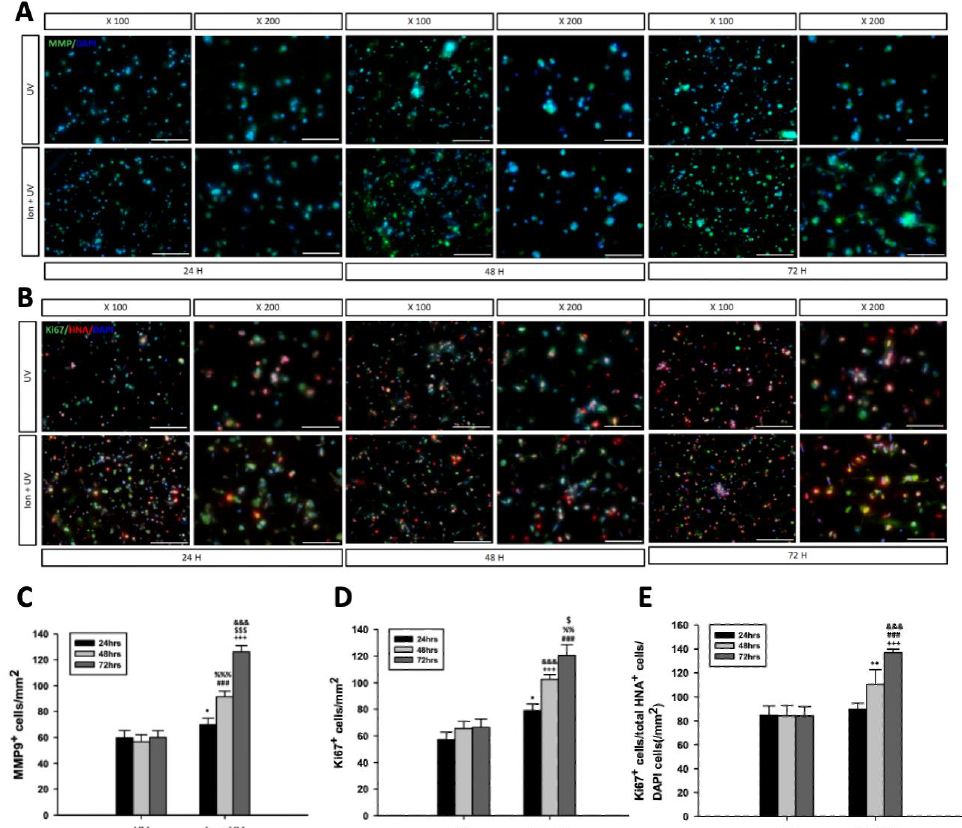
Figure 7. Immunocytochemistry staining assay. ( A ) Fluorescence images showing